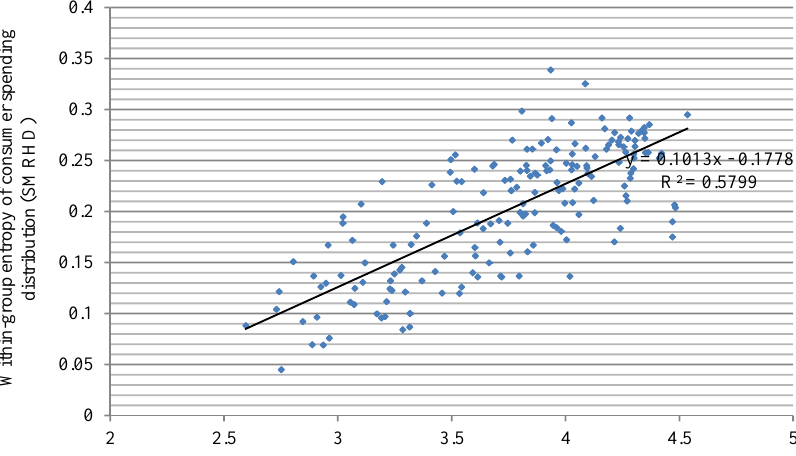
Figure 3. Linear regression for link "the absolute size of consumer spending — a measure of diversity of consumer spending (within-group entropy for SMRHD)"